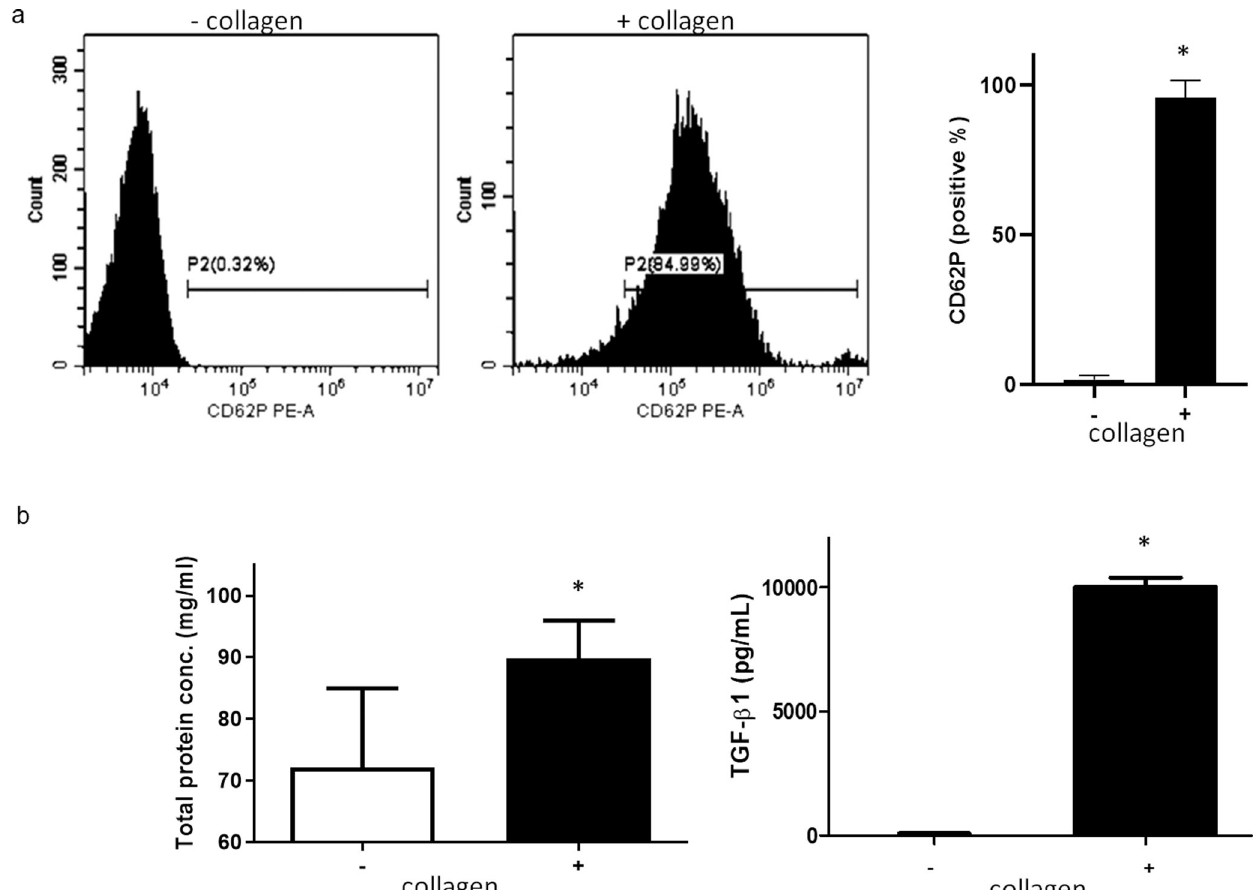
Fig. 3 Activation of PRP. a Detection of platelet activation marker CD62 by FACS. b Left: Total protein levels in activated PRP was signi fi cantly higher than in resting state. Right: By ELISA assay, the level of TGF- β in activated PRP was signi fi cantly higher than resting state (*, P < 0.0001). PRP, platelet-rich plasma, CD62P cluster of differentiation 62, FACS fl uorescence-activated cell sorting, RT PCR reverse transcription polymerase chain reaction, TGF- β transforming growth factor